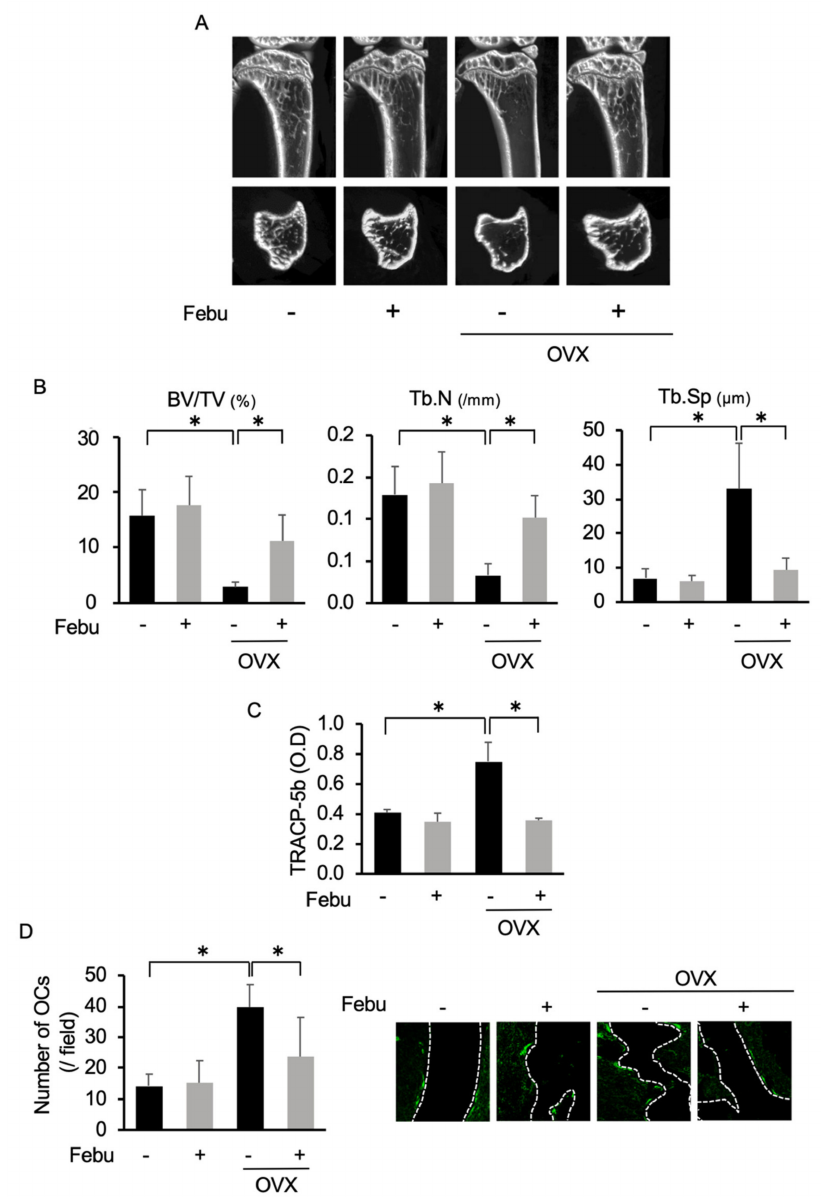
Figure 5. Febuxostat ameliorates bone loss in ovariectomized (OVX) mice. Sham-operated or OVX mice were treated for 3 weeks with or without febuxostat (Febu). µ CT images were then taken. ( A ) Representative µ CT images of sham and OVX mice with or without febuxostat (Febu) treatment are shown. ( B ) Bone volume / total volume (BV / TV), trabecular number (Tb.N), and trabecular separation (Tb. Sp) were calculated based on µ CT images of the tibiae ( n = 4 for each group). Results are expressed as mean ± SD. * p < 0.05. ( C ) The sera of sham and OVX mice were collected and serum levels of TRACP-5b were measured. Data are expressed as mean ± SD (n = 4 for each group). * p < 0.05. ( D ) The tissue sections of tibiae ( n = 4 for each group) were stained with anti-cathepsin-K antibody to identify OCs, and OC numbers per field were counted. Data are expressed as mean ± SD. * p < 0.05. Representative photos are shown. Original magnification, ×